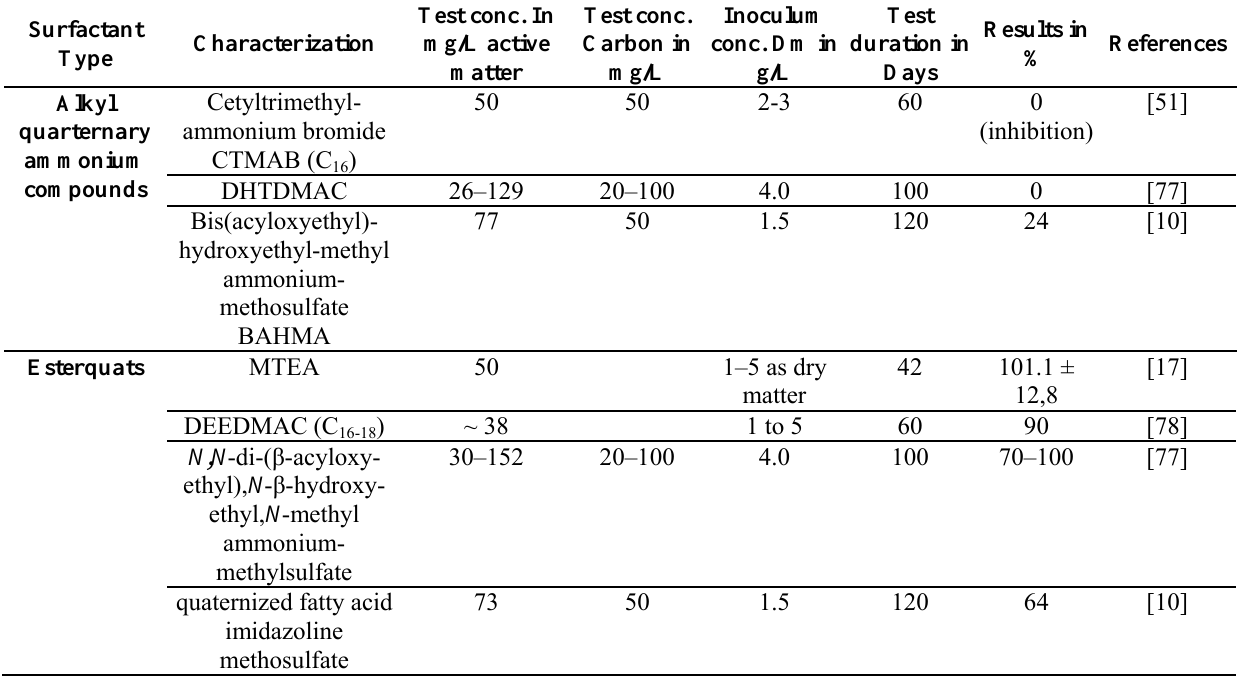
Table 7. Anaerobic biodegradability of cationics in screening tests (according ECETOC). Surfactant